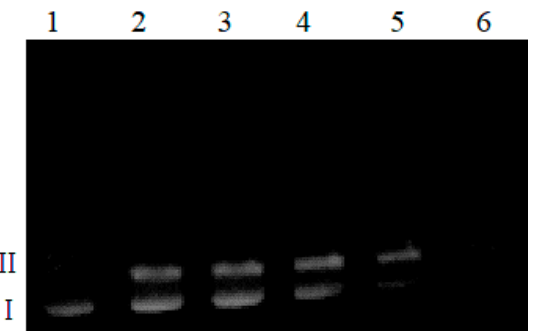
Figure 8. Plasmid DNA cleavage in the presence of Ac-FGEHEHGRD-NH 2 (samples incubated for one hour at 37 °C). Lane 1 : plasmid; lane 2: plasmid + 10 µM ligand; lane 3: plasmid + 50 µM ligand; lane 4: plasmid + 100 µM ligand; lane 5: plasmid + 500 µM ligand; lane 6: plasmid + 500 µM ligand.